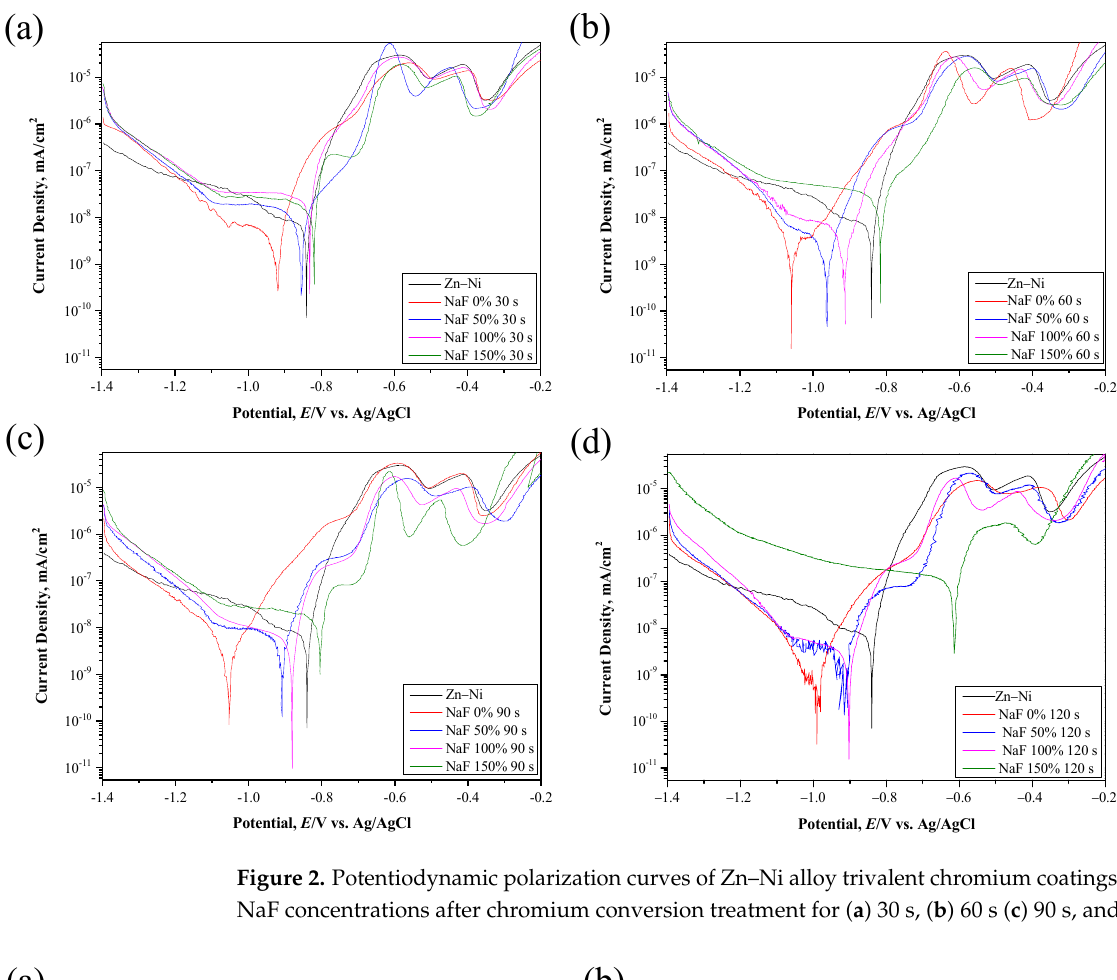
Figure 2. Potentiodynamic polarization curves of Zn–Ni alloy trivalent chromium coatings at various NaF concentrations after chromium conversion treatment for ( a ) 30 s, ( b ) 60 s ( c ) 90 s, and ( d ) 120 s.